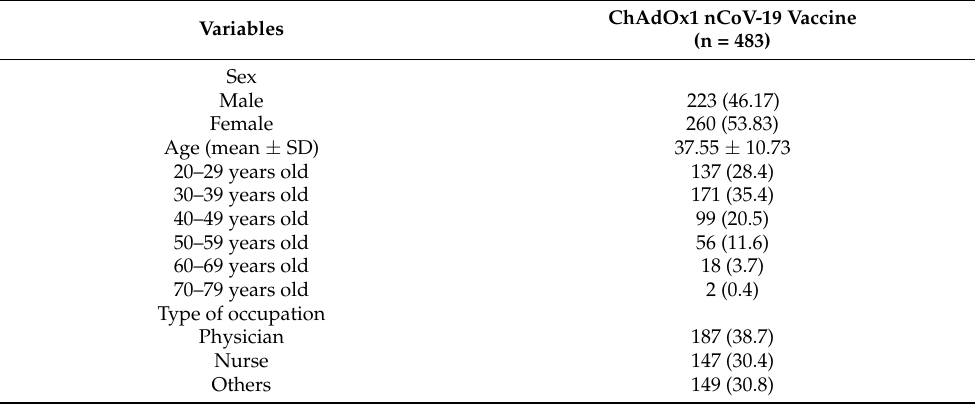
Table 1. Participant characteristics of COVID-19 vaccine